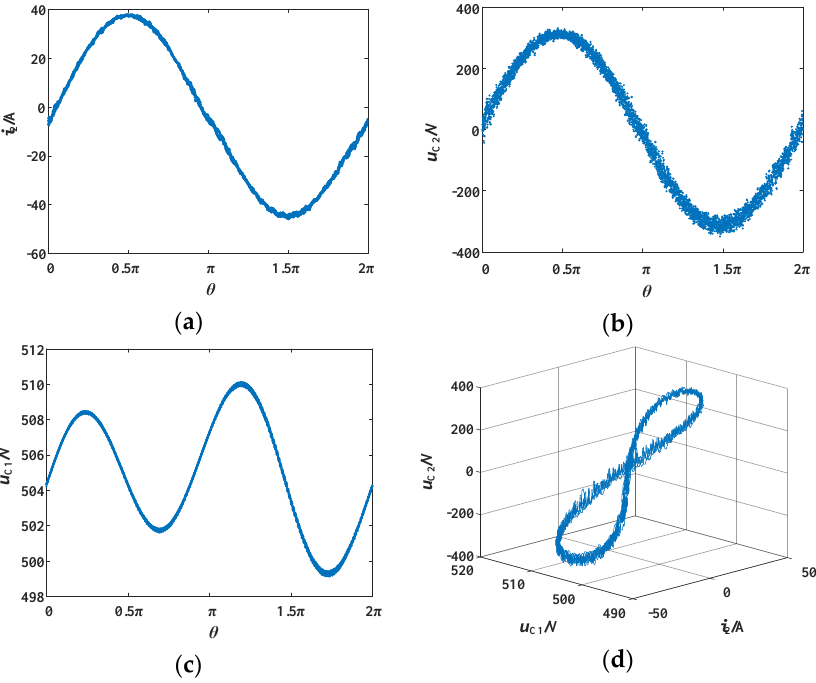
Figure 6. Quasiperiodic motion at η 0 = 0.5 and η 1 = 0.9. ( a ) Folded diagram of output current i 2 ; ( b ) Folded diagram of output voltage u C2 ; ( c ) Folded diagram of output voltage u C1 of the photovoltaic array; ( d ) Phase diagram of quasi-periodic motion of i 2 , u C2 and u C1